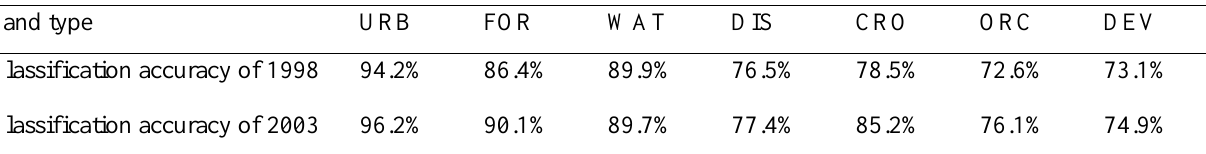
Table 1 The classification accuracy results of each land